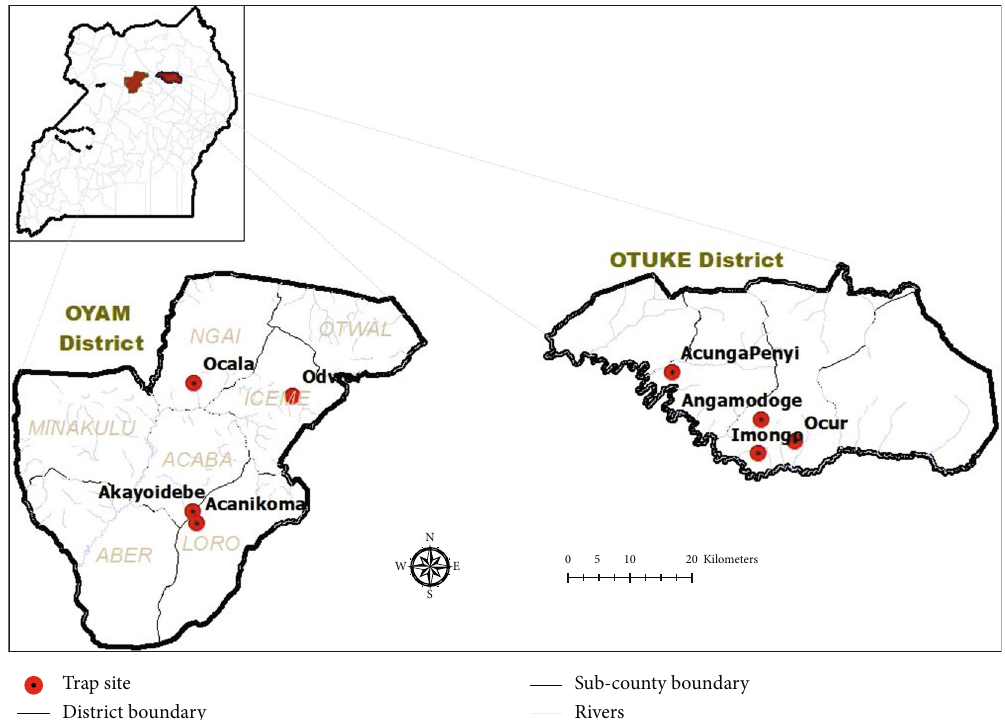
Figure 1: Map of study area showing trapping sites. In the upper left hand corner is the inset map of Uganda showing the location of the two surveyed districts, while below it are the maps of the two districts showing the sampling